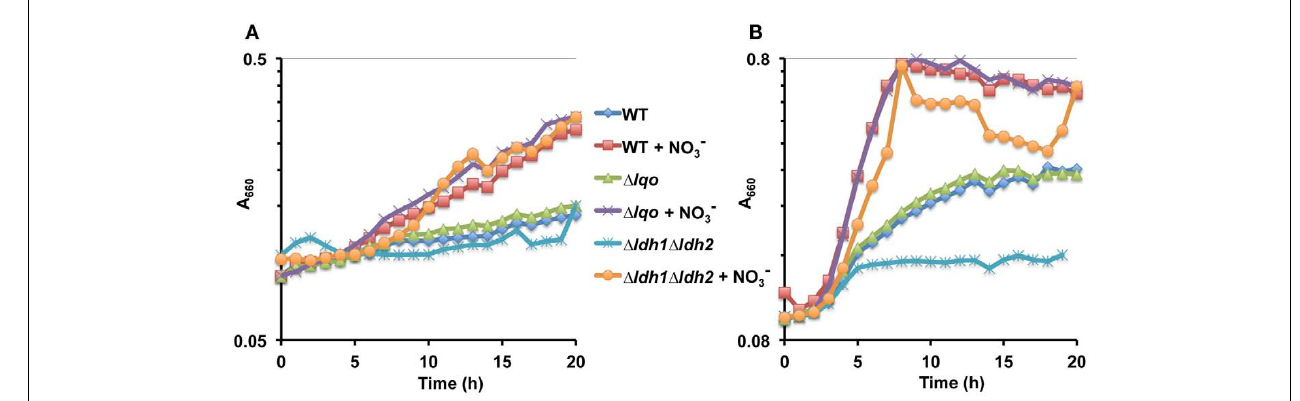
FIGUREA4 | Lqo-mediated growth on L-lactate under anaerobiosis respiratory electron acceptor. (B) Representative growth curve ofWT requires an electron acceptor. (A) Representative growth curve ofWT S. S. aureus strain Newman and isogenic mutants cultured anaerobically in aureus strain Newman and isogenic mutants cultured anaerobically in chemically defined medium with a combination of 1.0% tryptone and chemically defined medium with 1.0% L-lactate as the primary carbon source. L-lactate as the primary carbon source.When indicated, nitrate was added When indicated, nitrate was added (NO − (NO − at 40mM) as an anaerobic at 40mM) as an anaerobic respiratory electron acceptor. 3 3